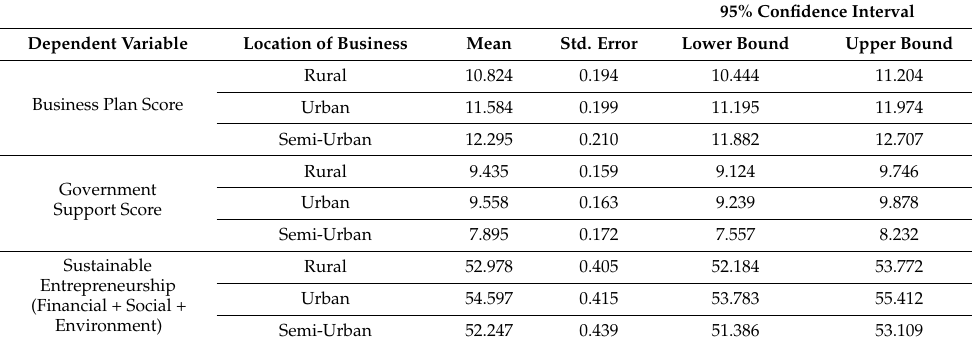
Table 11. Estimated marginal means (location of business) estimates.